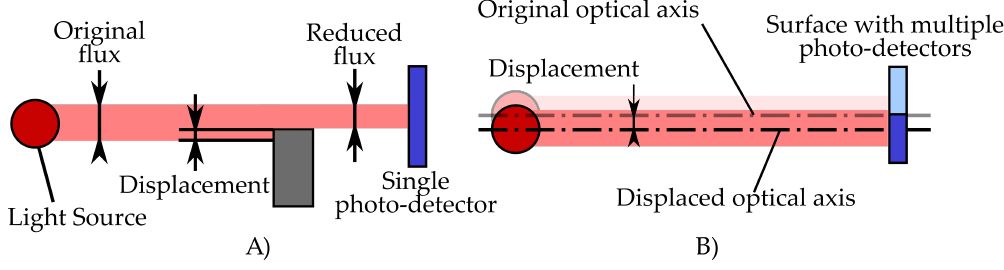
Figure 1. Optical micrometric sensors strategies. ( A ) light incidence is modified by occlusion of the photo-detector. ( B ) displacement is measured by modifying the position of the focus point in a matrix of